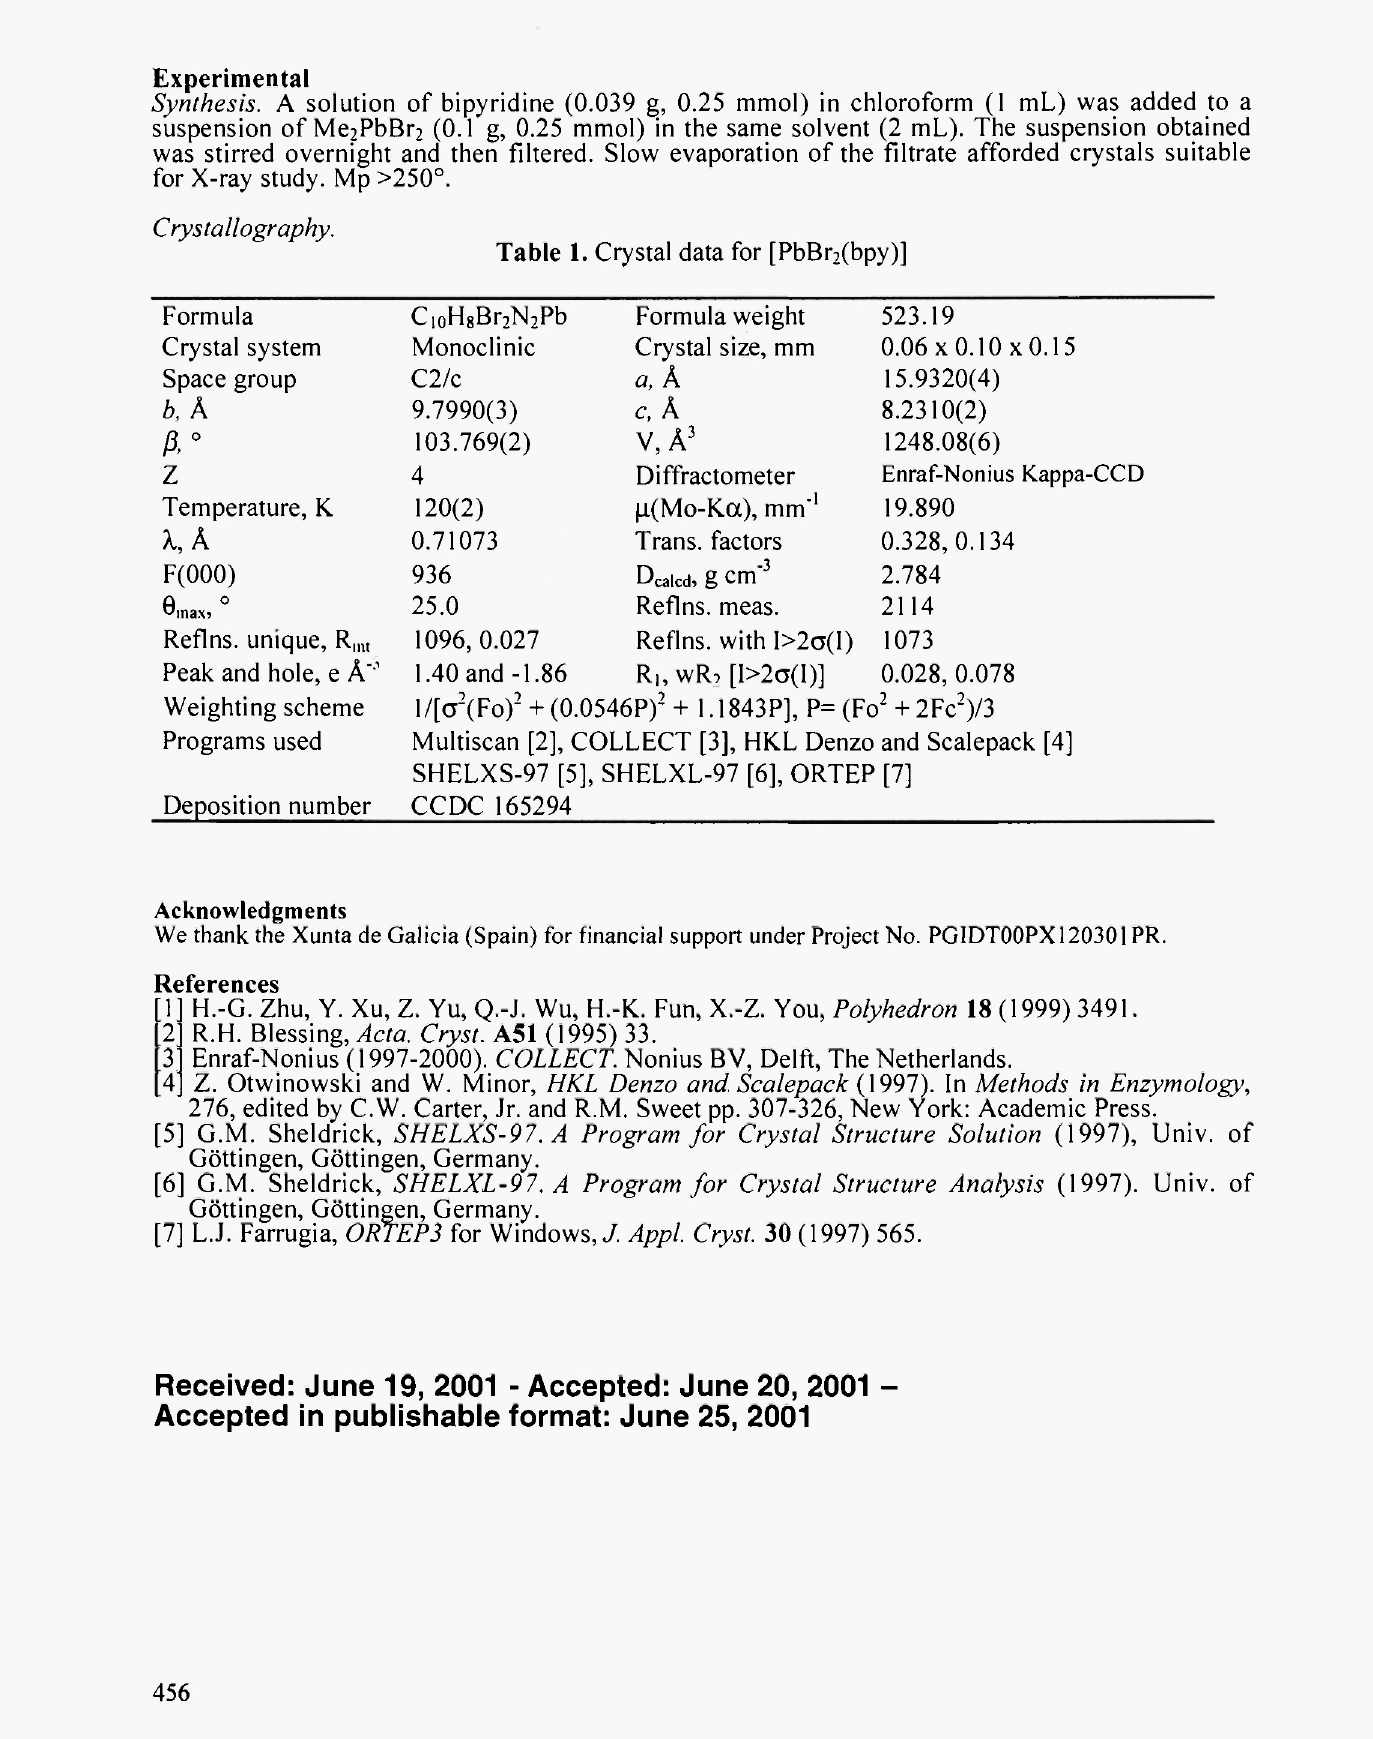
Table 1. Crystal data for [PbBr 2